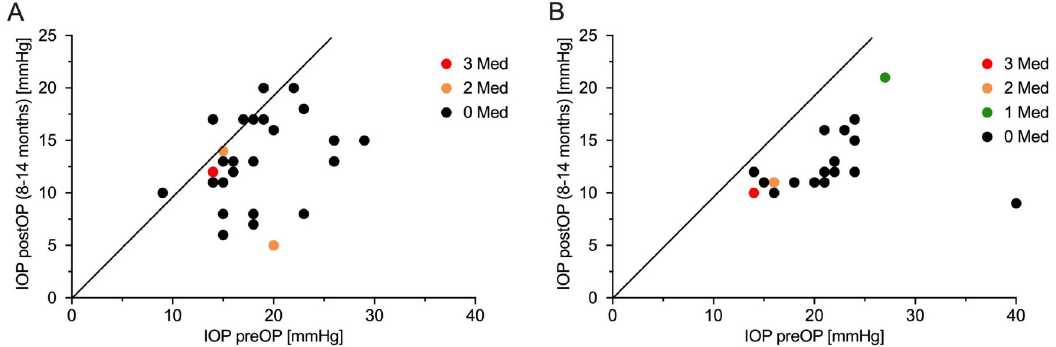
Fig 2. Scatter plot of intraocular pressure preoperatively versus one year postoperatively. (A) Primary open angle glaucoma; (B) Pseudoexfoliation glaucoma. Plotted according to number of antiglaucomatous medication at one year postoperative. IOP = intraocular pressure; preOP = preoperative; postOP = postoperative; Med = antiglaucomatous medication.